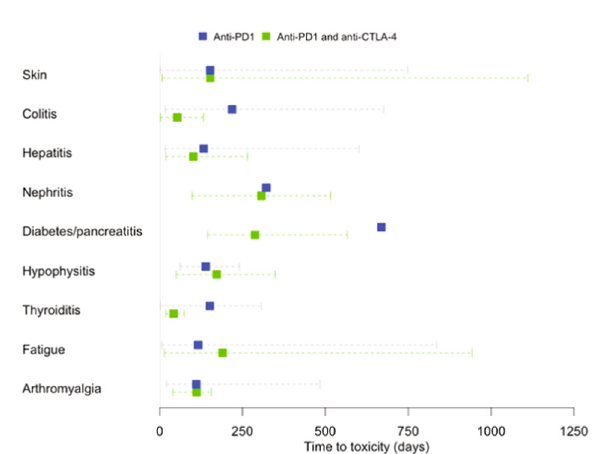
Fig. 2 Time to onset of irAE based on the ICI GENETICS Study dataset (IRAS 237779, CPMS 39433). Time to toxicity for different irAE according to whether patients in the ICI Genetics study were treated with single anti-PD-1 or combined anti-CTLA-4 and anti-PD-1 therapy. The square box and dotted lines refer to the mean and range of the time taken from the treatment start date to development of toxicity in patients treated with anti-PD1 therapy (blue) ( N = 92) and anti-PD1 and anti-CTLA-4 therapy (green) ( N =